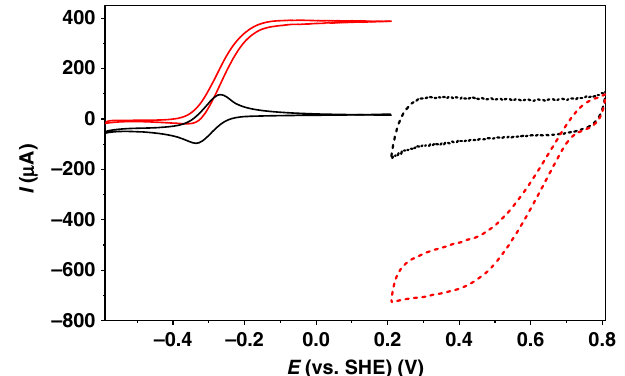
Fig. 2 Electrochemical characterization of the bioelectrodes. Cyclic voltammograms of a P(GMA-BA-PEGMA)-vio//P(N 3 MA-BA-GMA)-vio/ Dv MF-[NiFe] gas-diffusion bioanode (solid lines, left) and a Mv -BOx gas diffusion biocathode (dashed lines, right) in the absence (black lines) and presence of the respective substrate (red lines; bioanode: H 2 ; biocathode: air, no forced fl ow, passive breathing mode) in gas-breathing mode. Absolute currents are shown. Working electrolyte: 0.1 M phosphate buffer (pH 7.4); scan rates for all voltammograms: 10 mV s − 1 ;